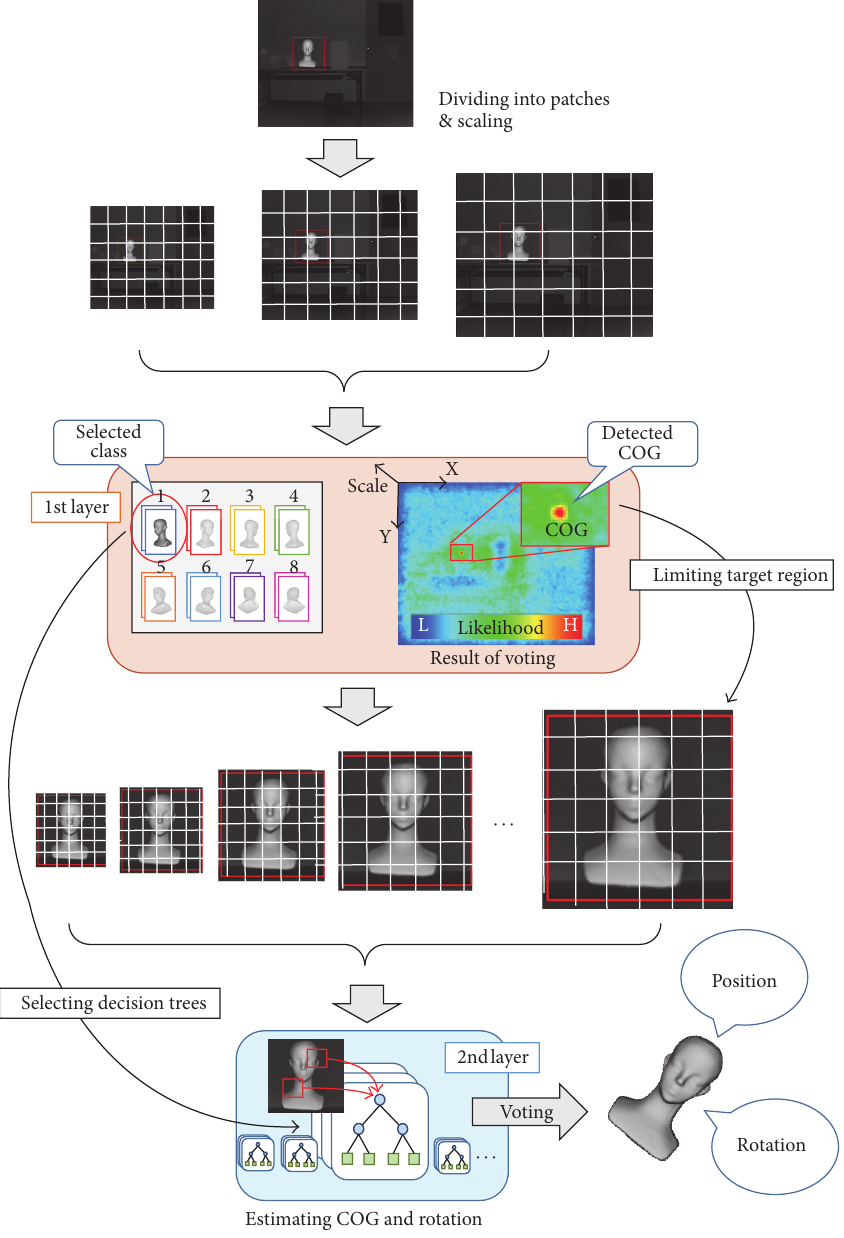
Figure 3: Detecting 3D position and